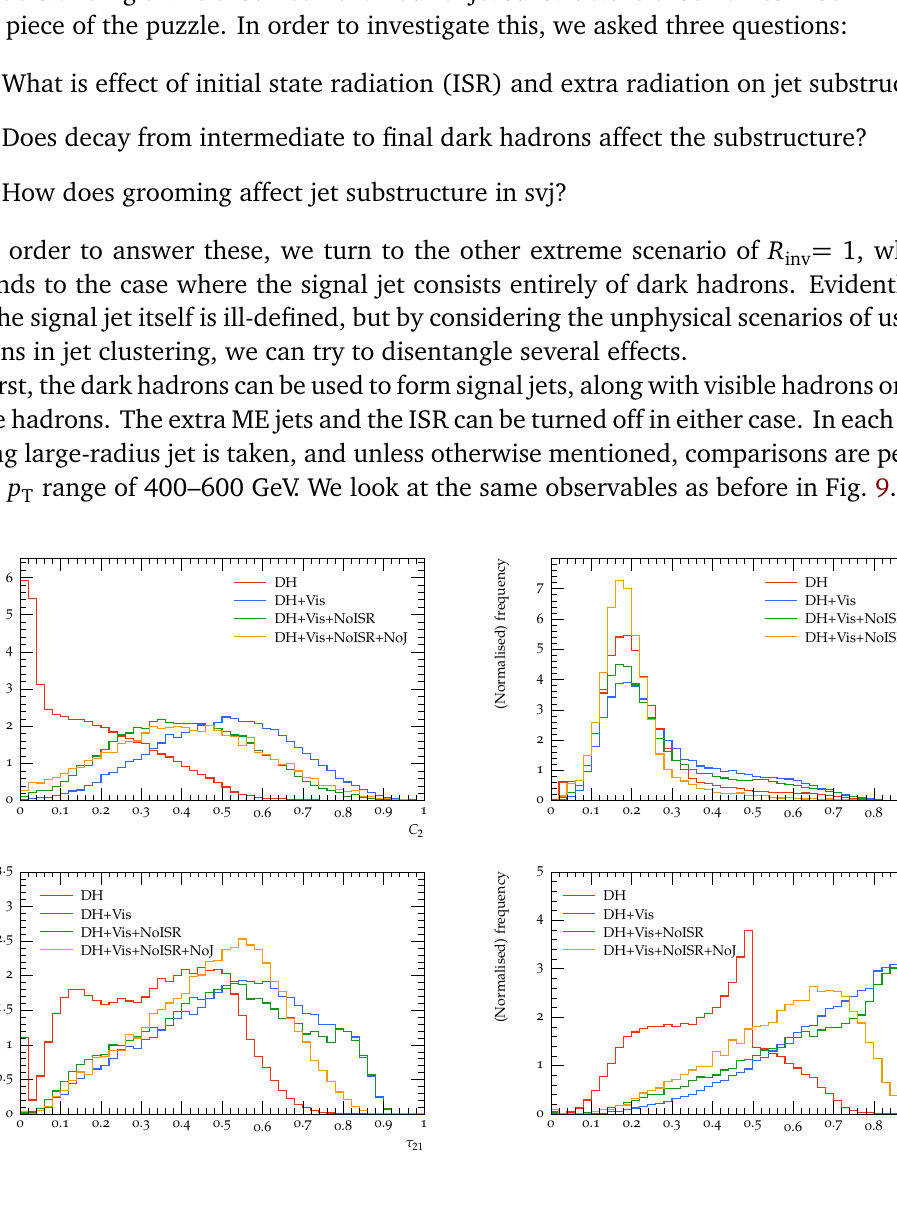
Figure 9: Comparisons of C (top left), LHA (top right), τ (bottom left) and τ 2 21 32 (bottom right) between different signals corresponding to clustering only with dark hadrons (DH), adding visible hadrons (Vis), tuning ISR off (NoISR), and also turning extra ME jets off